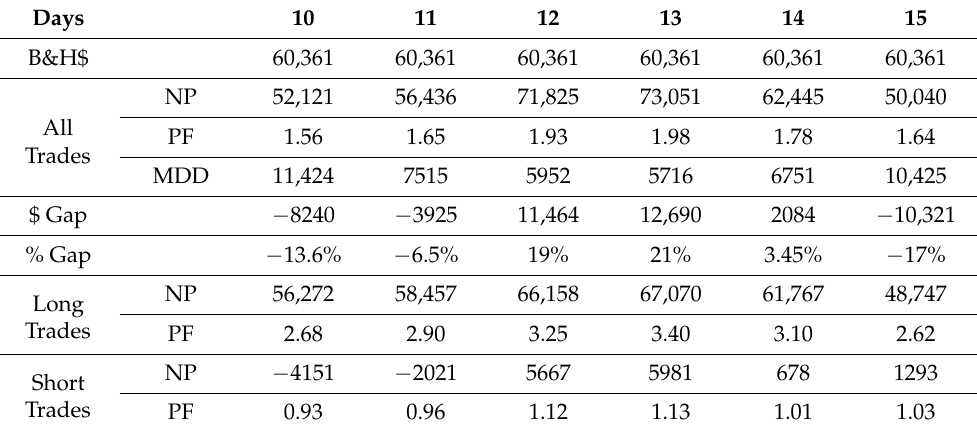
Table 1. Results for Bitcoin trades.